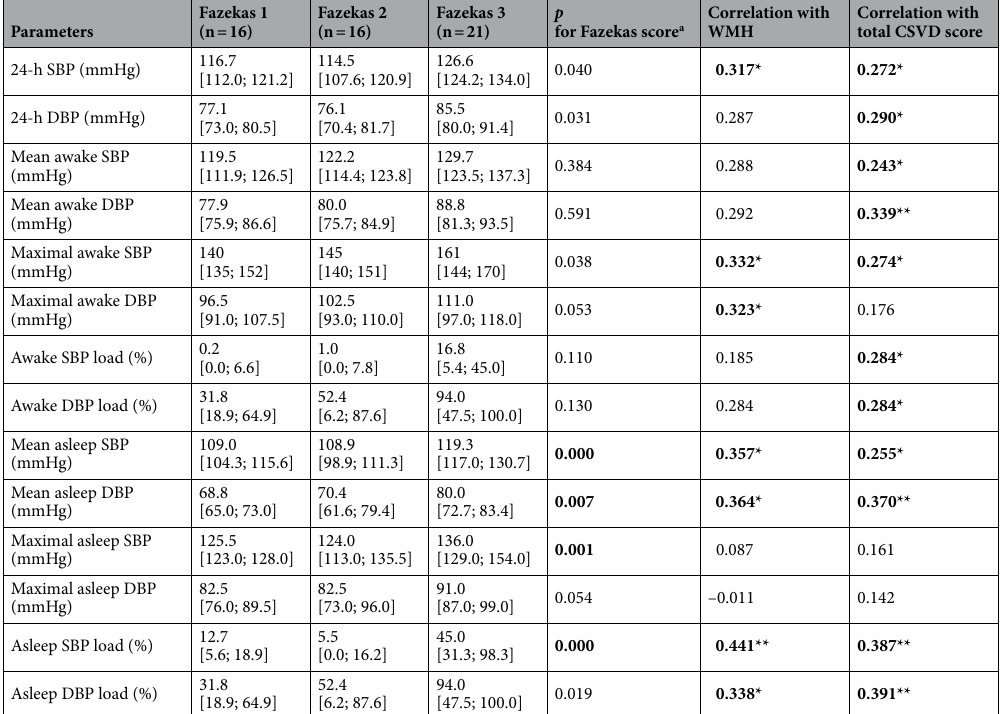
Table 4. Relationship between ABPM, WMH, and total CSVD score. a difference between groups were determined using univariate analysis of variance or Kruskal–Wallis test with Bonferroni correction, where appropriate. * p < 0.05. ** p < 0.01. Significant values are in bold.